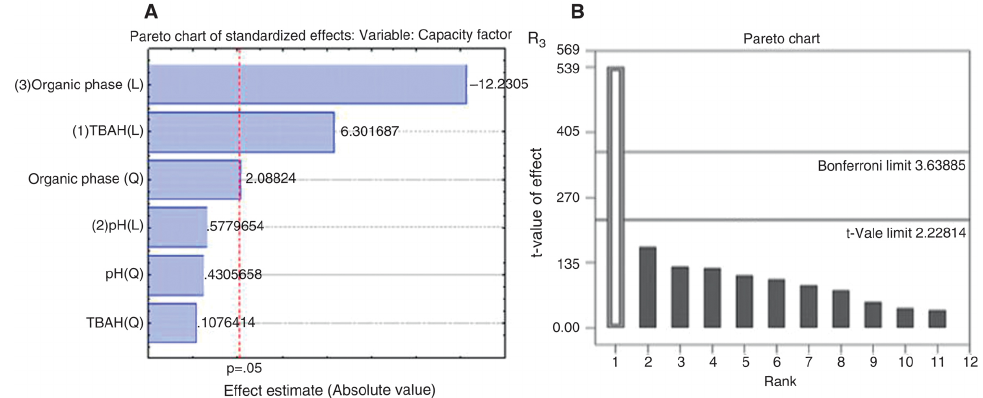
Figure 9: Pareto charts: (A) simultaneous influence of numerous variables on the capacity factor of eberconazole (Krishna et al. 2016). (B) A Pareto chart used for chromatographic optimization depicting the t -value effect and ranking generated by a computer program (Agrahari et al.